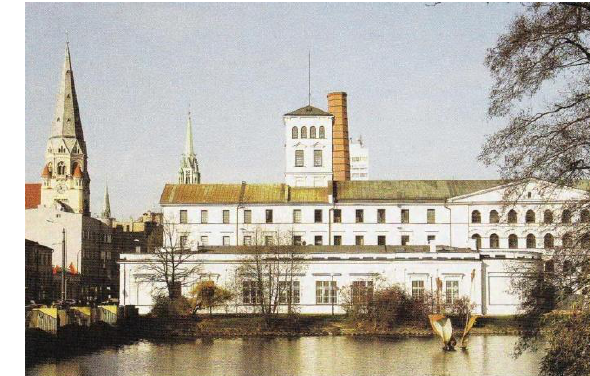
Fig. 7. L. Geyer’s White Factory from the 19th century in 282-284 Piotrkowska Street ( A. Kurycki )